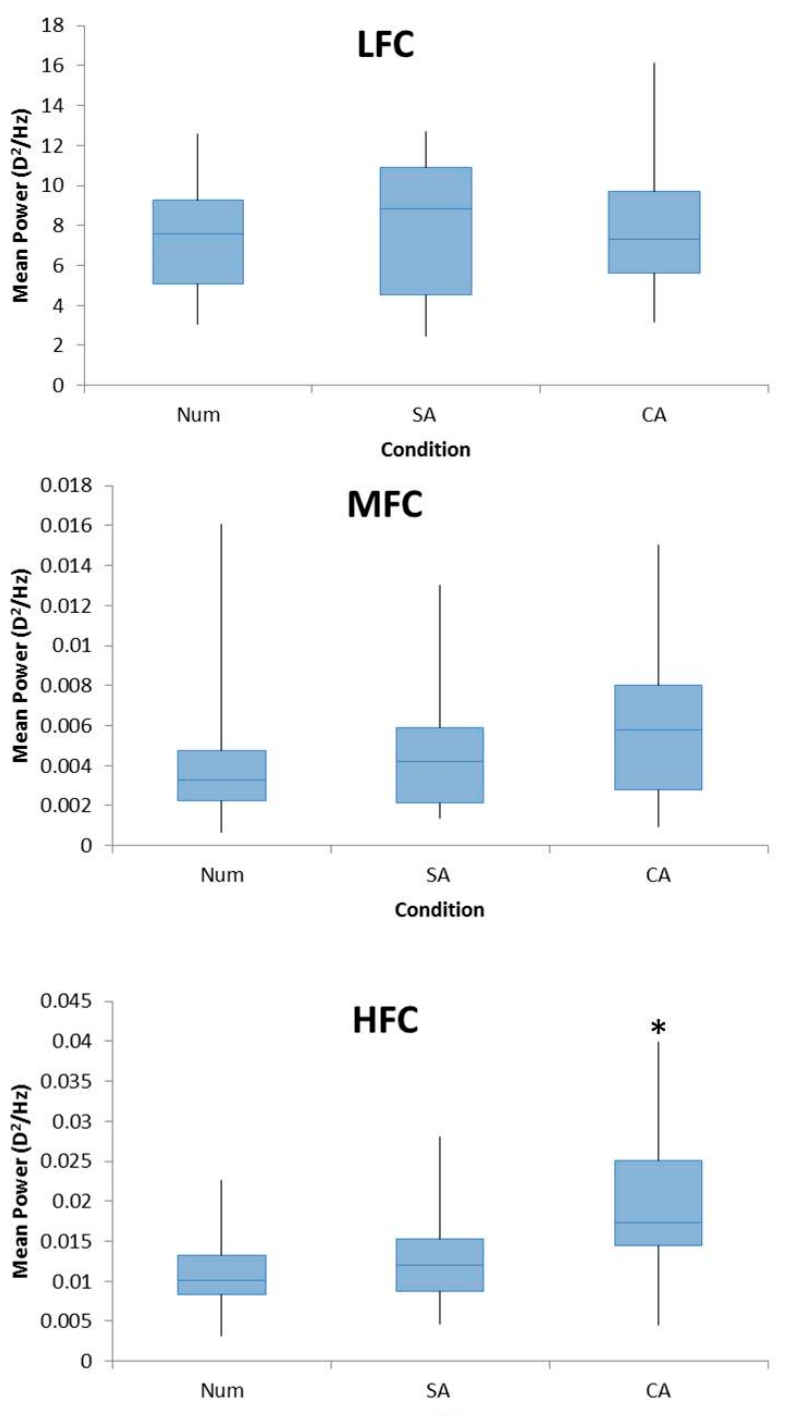
Figure 3. Box plots demonstrating the mean power of FFTs for the LFC ( top ), MFC ( middle ), and HFC ( bottom ) for all participants for the conditions Num, SA, and CA. A repeated measures ANOVA with Bonferroni post-hoc analysis found a significant effect for HFC with a significant difference between CA and SA and CA and Num conditions. No significant effect was found for LFC or MFC.